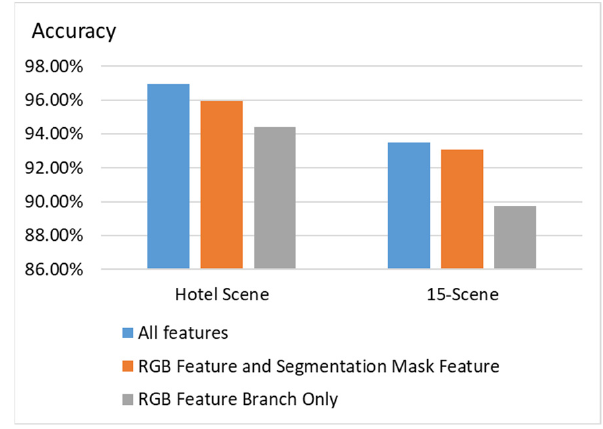
Figure 9. Experiments on different feature combinations.